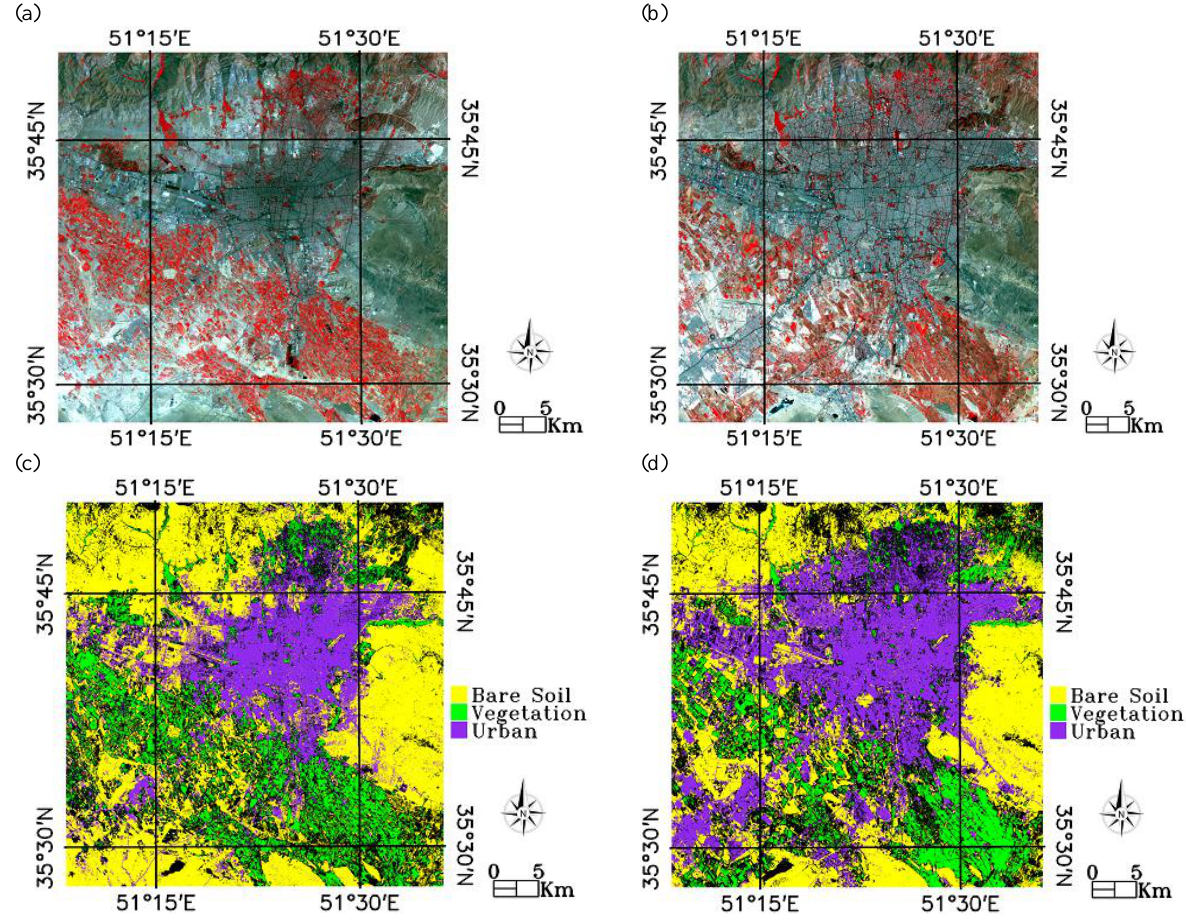
Figure 2, Tehran expansion between YEATS 1985 and 2010. (a) False color combination of TM image in 1985, (b) false color combination of TM image in 1985, (c) classified image 1n 1985, (d) classified image in 2010.